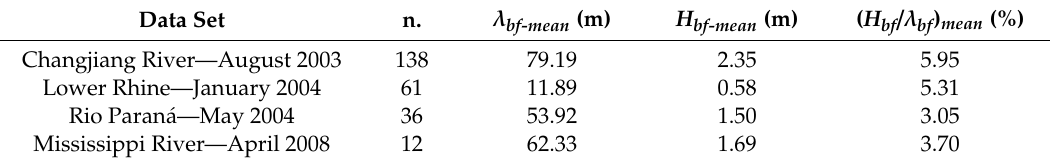
Table 10. Main parameters of bedforms from the literature data sets. Legend: λ bf-mean = mean of the